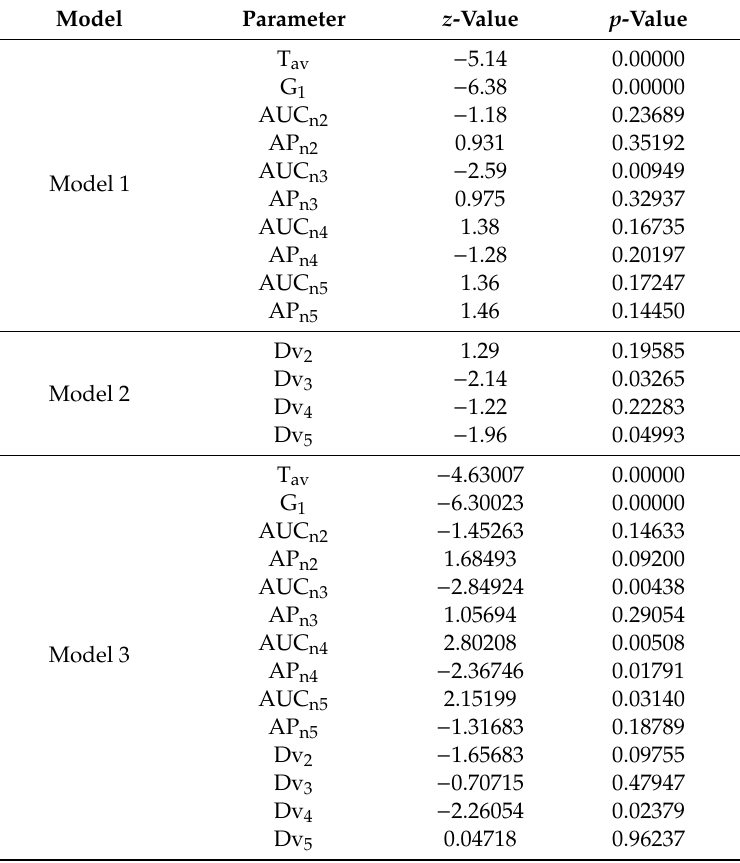
Table 3. Summary of the application of Binomial Generalized Linear Model with Logistic Regression (GLM) to the three